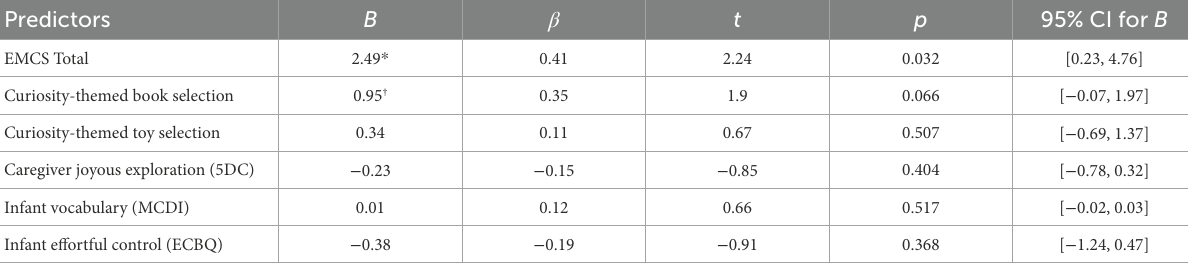
TABLE 2 Multiple regression analysis summary of infants’ average Preference